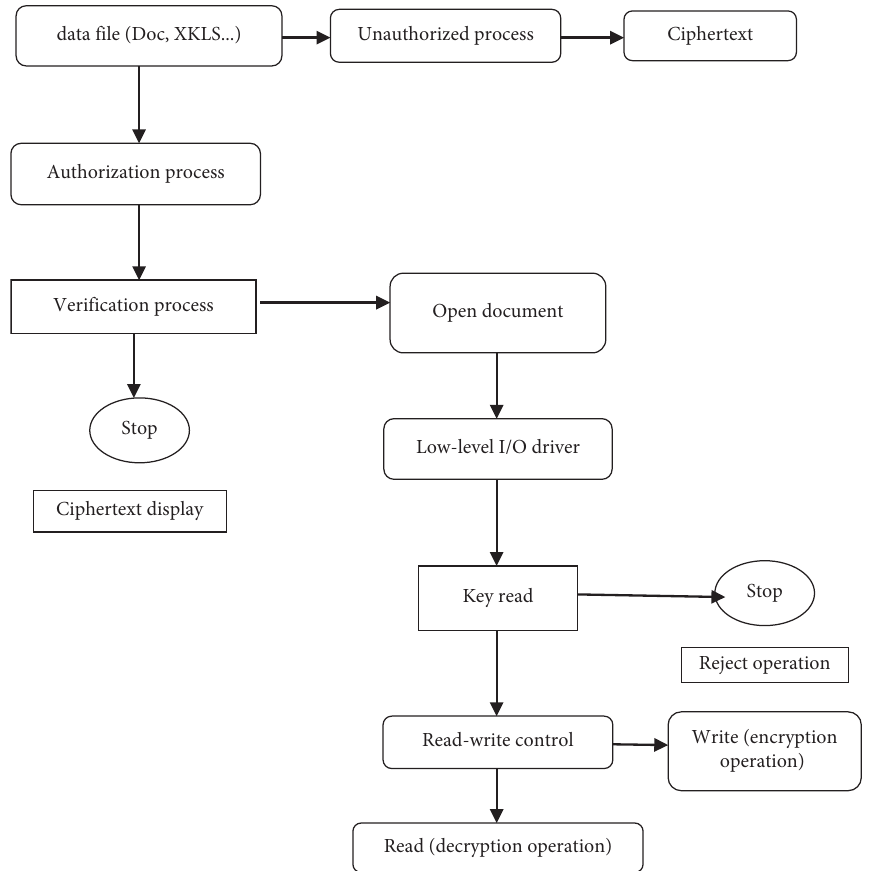
Figure 4: Flowchart of document security protection